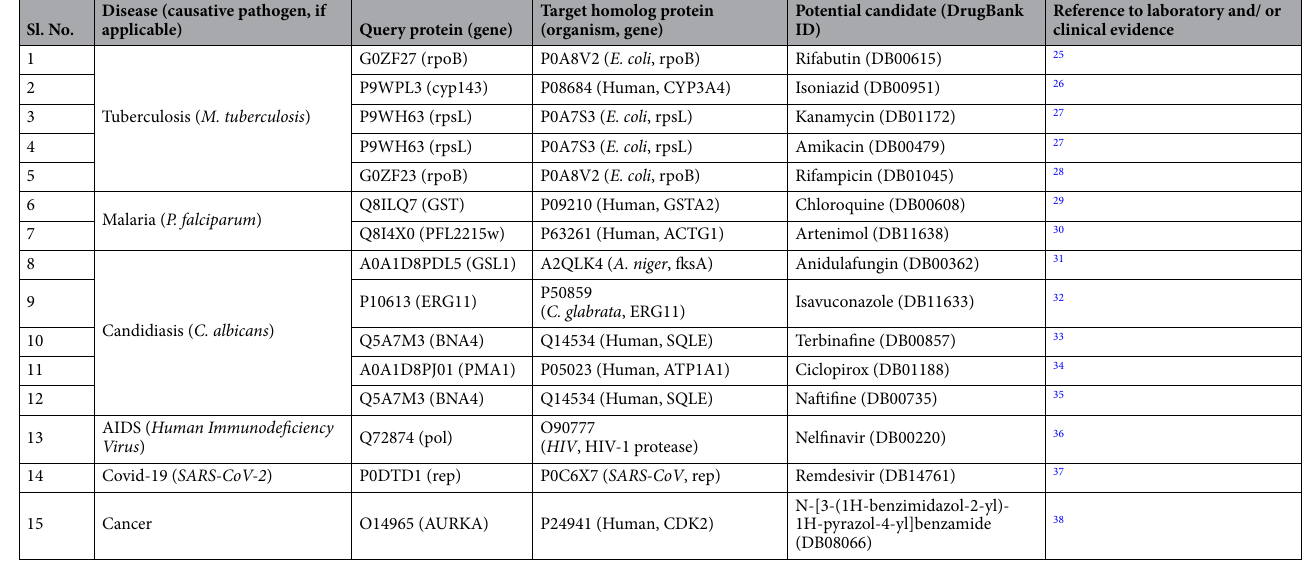
Table 1. Few selected examples from validation of NOD’s predictions. P.S.: In the case where the candidate molecules are associated with more than one query-target pairs, only a single non-trivial (i.e., non-self hit) pair is selected for reporting in this table. Information on detailed validation results of NOD could be found in the Table